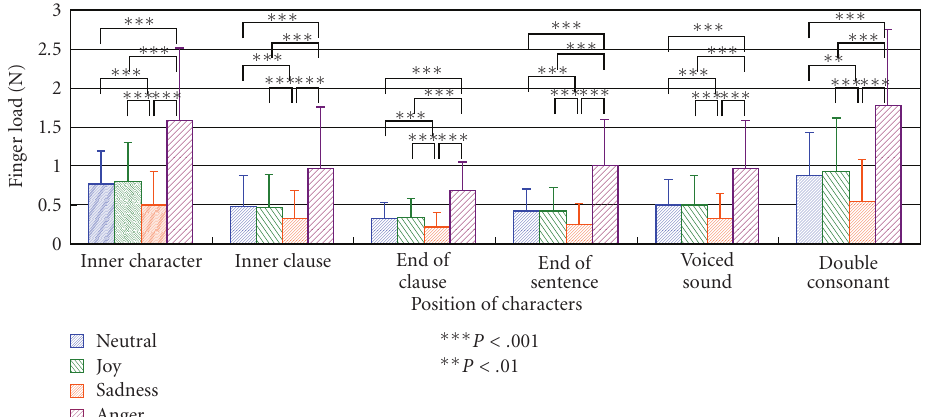
Figure 22: Mean of finger load as a function of emotions and position of characters (error bars represent standard deviations).